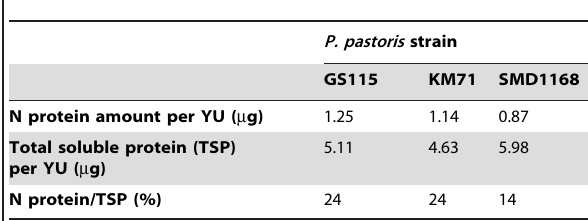
Table 1. Amount of N protein expressed in P. pastoris GS115, KM71 and SMD1168 strains. One YU corresponds to 10 7 yeast